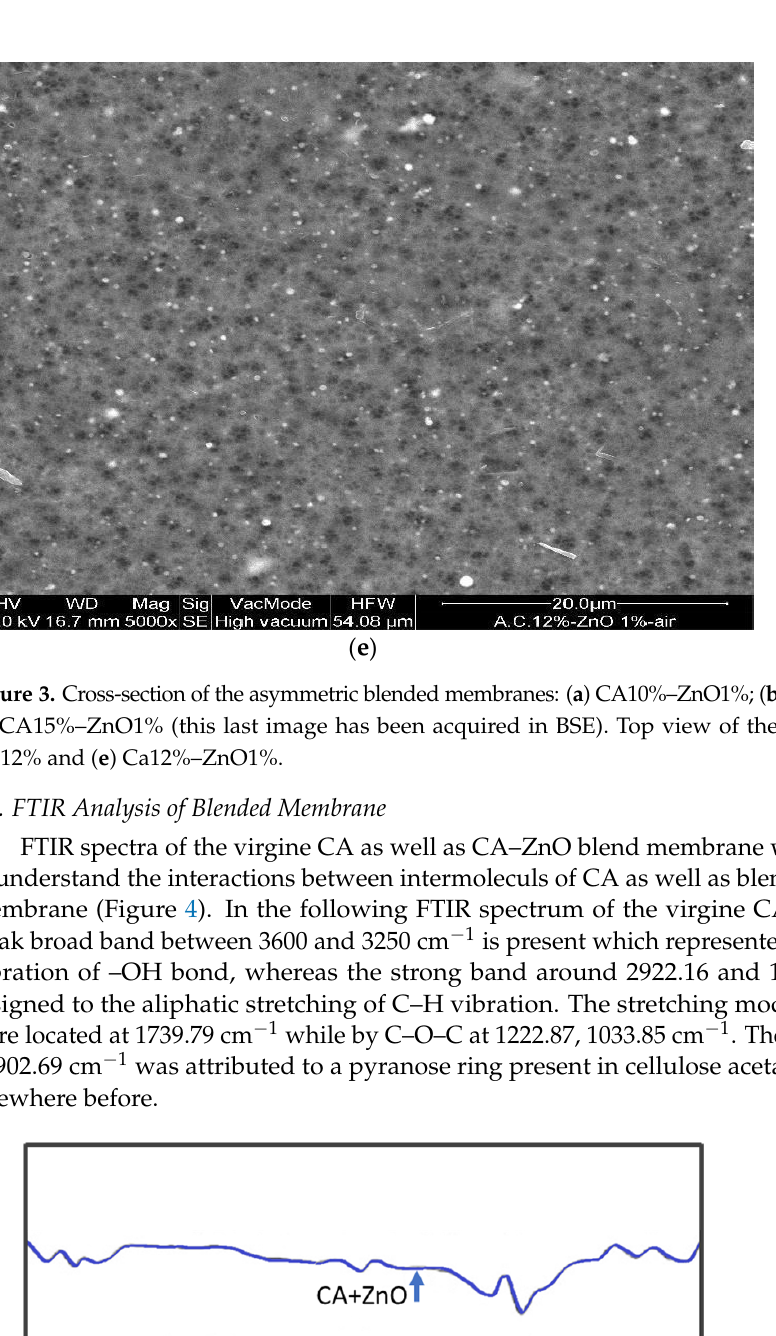
Figure 5. Tensile strength and Young’s modulus of the CA membranes prepared at different poly- mer concentrations. In order to investigate the effect of ZnO in Figure 5, tensile strength and Young’s modulus of membranes n. 1, 2, 3 and 4 are reported. For a fixed content in CA (10%) and different amounts of ZnO the Figure 6 shows a decrease in Young’s modulus and an in- crease in tensile strength for the membrane with 1 and 2% of ZnO. The standard deviation resulted as less than 5%. This result was derived from the incorporation of ZnO additive could be due to the increased flexibility of the CA chains caused by a good interaction between the filler particles (ZnO) and the polymeric chains of CA and consequently trans- ferred the stress between fillers and polymer, thus showing a lower modulus and higher strength. However, with a higher percentage of ZnO (3%) the filler polymer interactions may decrease, and an opposite effect is observed with higher Young’s modulus but lower strength. The mechanical stability of the blended membranes increased with the ZnO concen- tration up to 1 wt% of ZnO. However, increasing the ZnO content further was observed